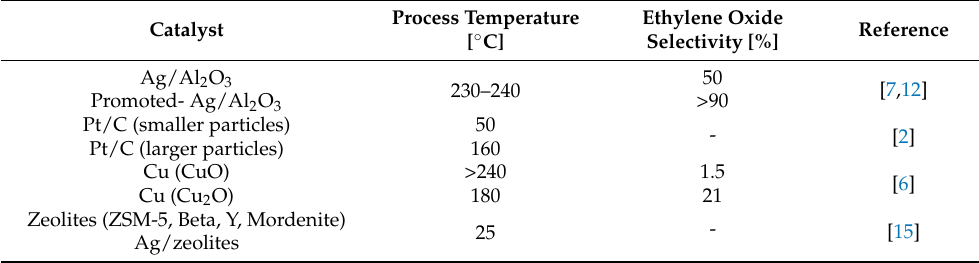
Table 1. Methods for the ethylene oxide